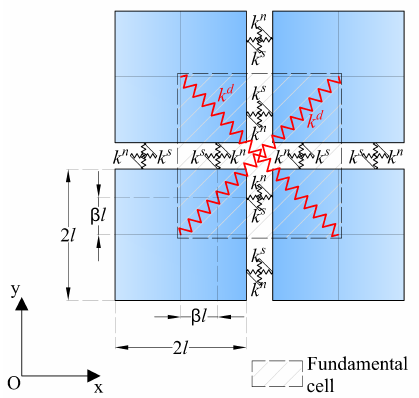
Figure 8. Fundamental cell of the RBSM with diagonal springs.